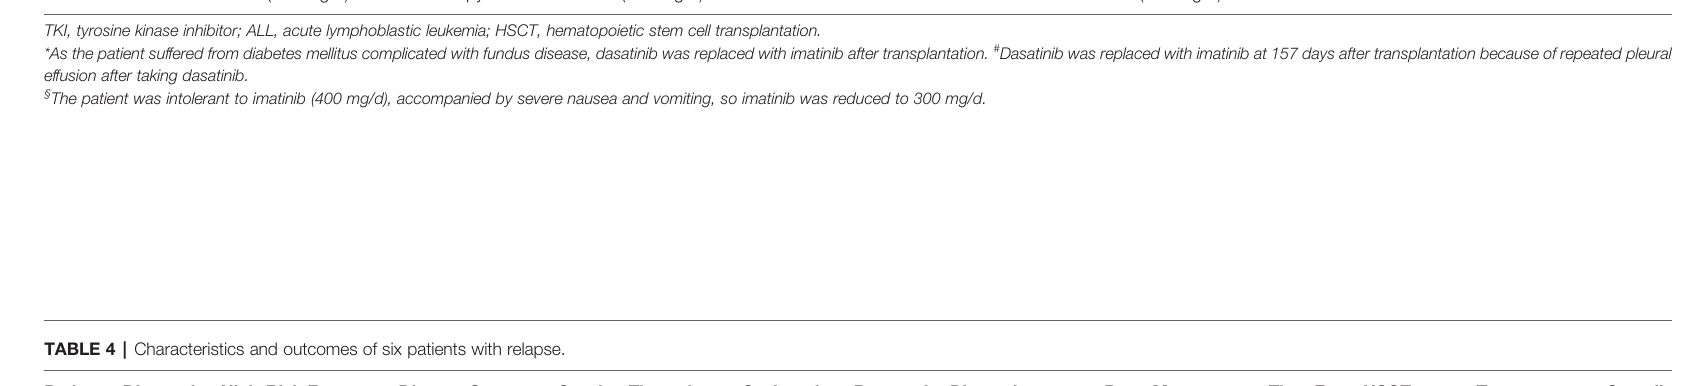
TABLE 4 | Characteristics and outcomes of six patients with relapse. Patient